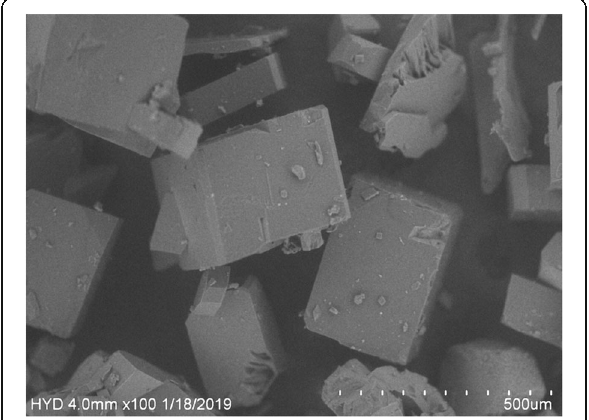
Fig. 1 SEM image of 0.065 g/ml of solute in methanol obtained by solvent evaporation method carried out for 48 h with no stir (× 100)